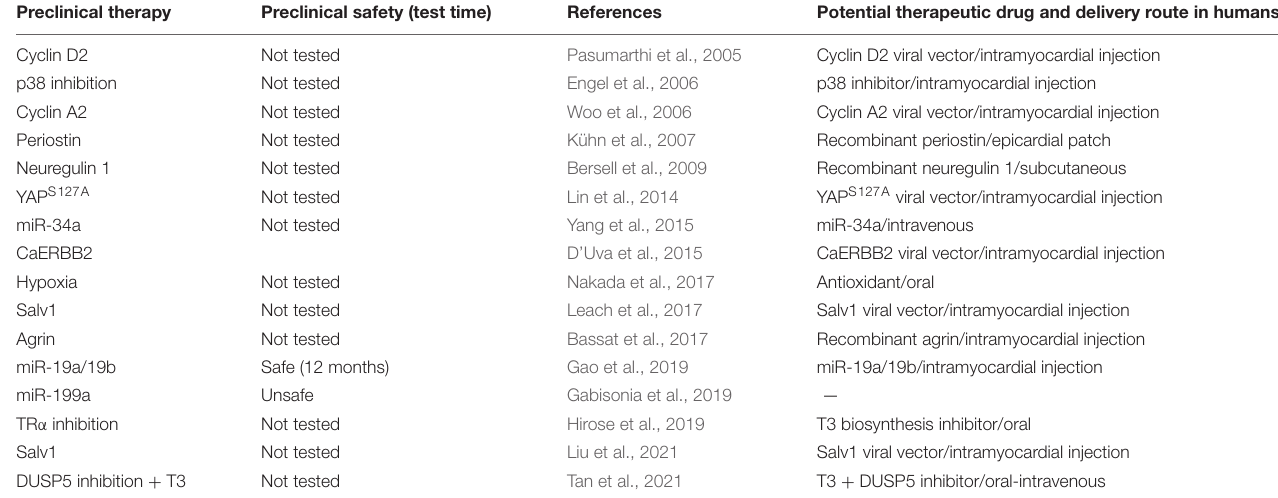
TABLE 2 | Potential translation strategies based on preclinical research. Preclinical